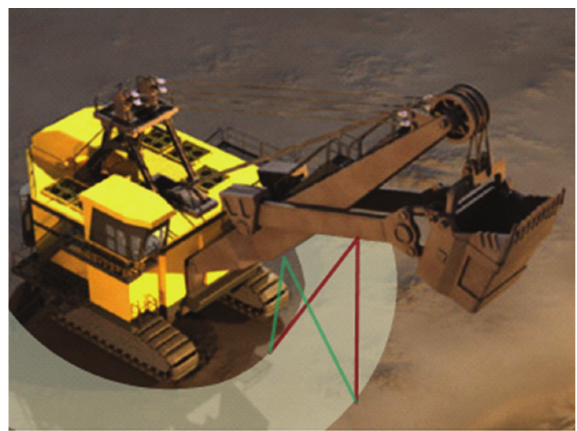
Figure 1: Artists impression of radar system on-board an electric- rope-shovel, showing the approximate radar imaging region in grey for the given bistatic antenna configuration. Further receivers could then be added along the shovel arm to extend this to a full multistatic